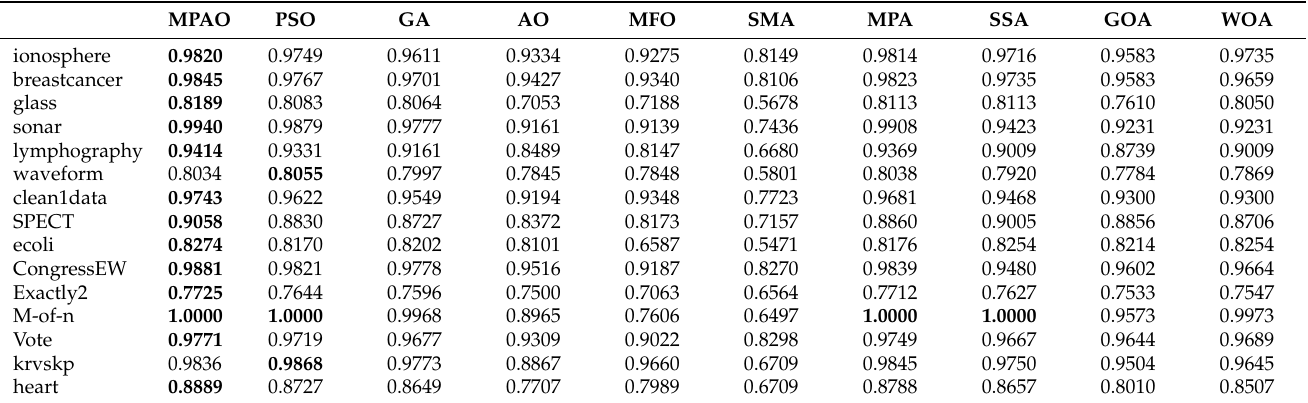
Table 13. Results of the accuracy measure for all